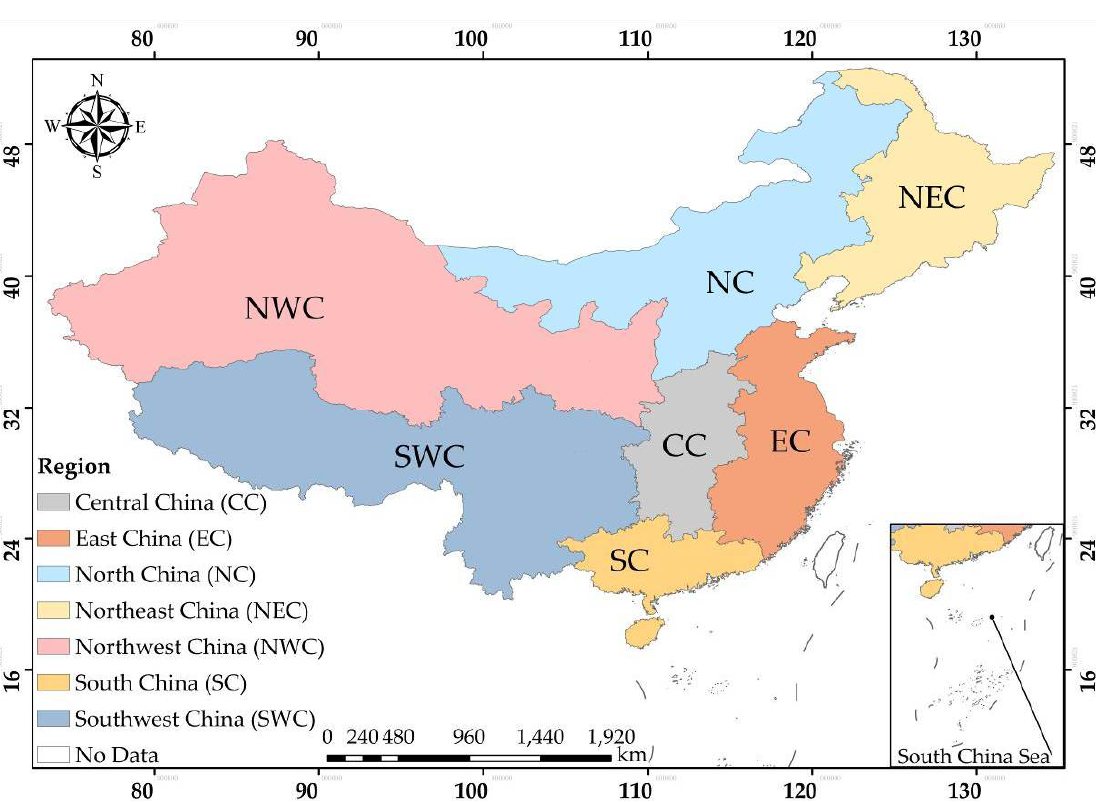
Figure 1. Geographical locations of seven regions in China.